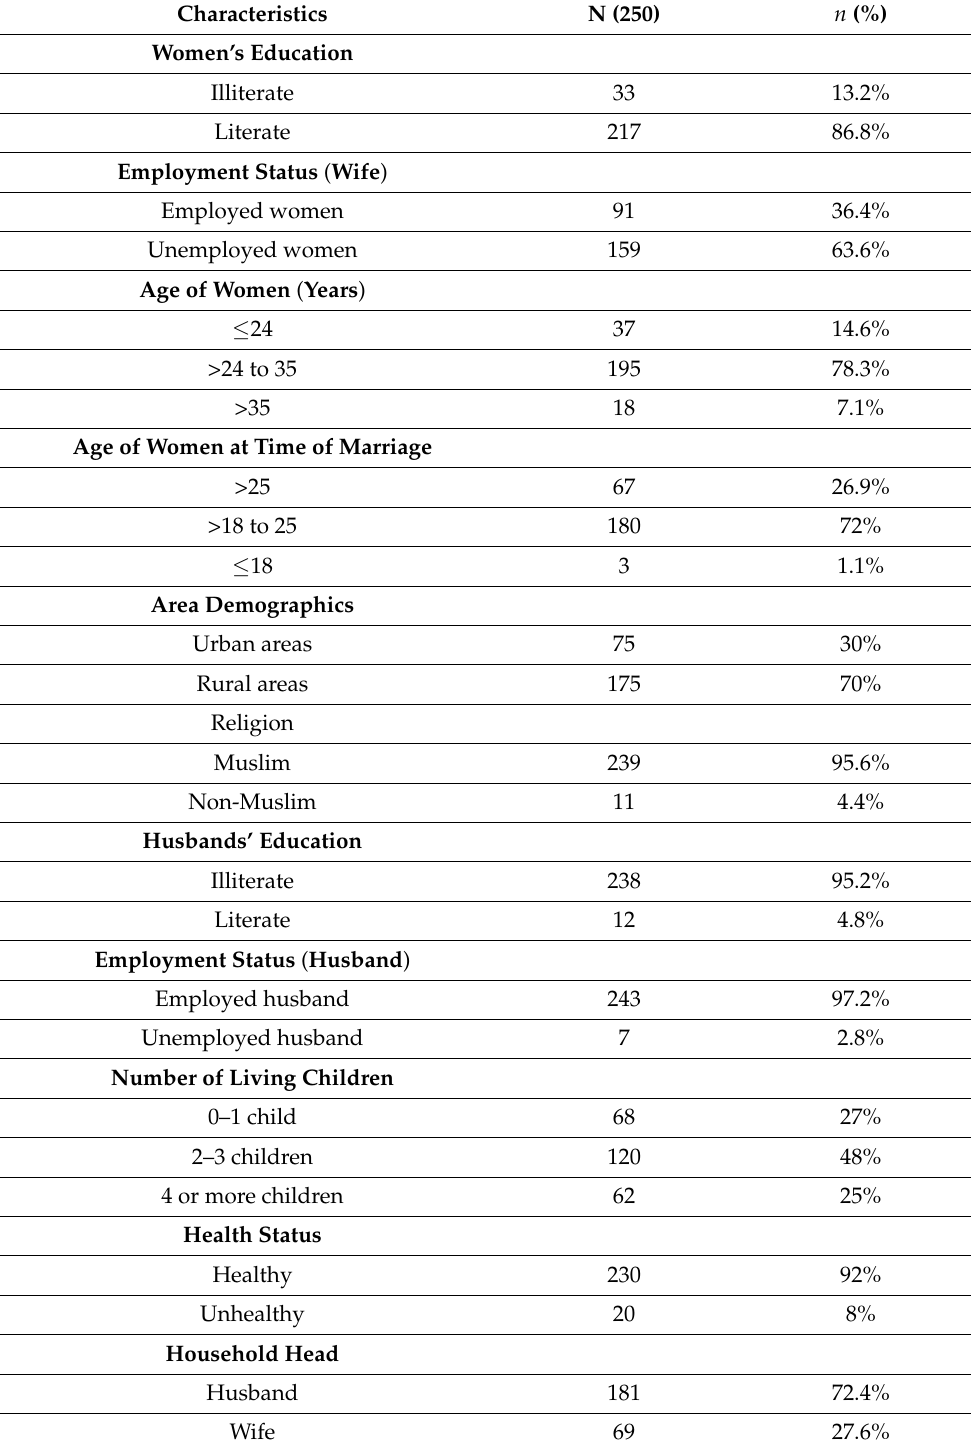
Table 1. Socio-demographic characteristics of